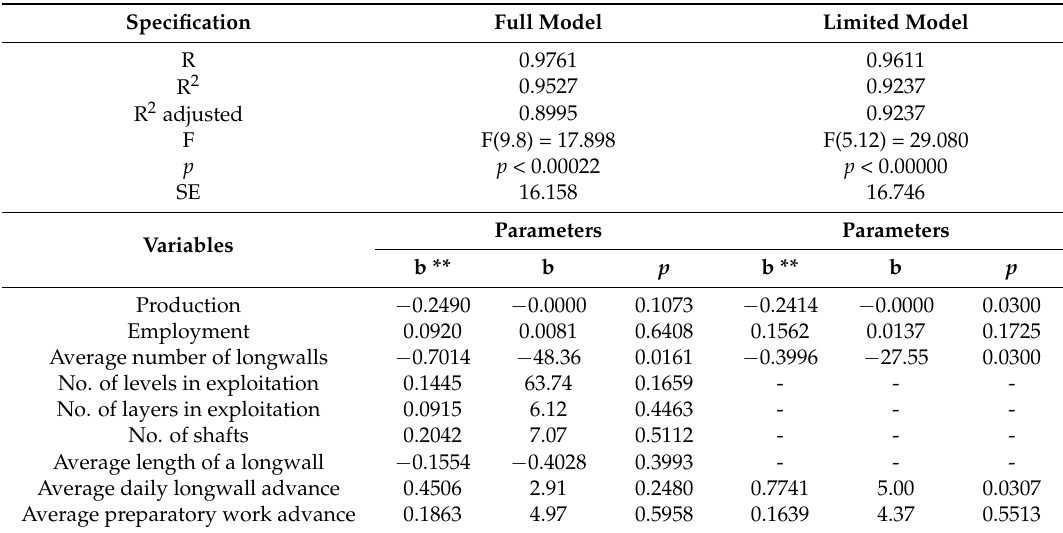
Table 6. Regression models for